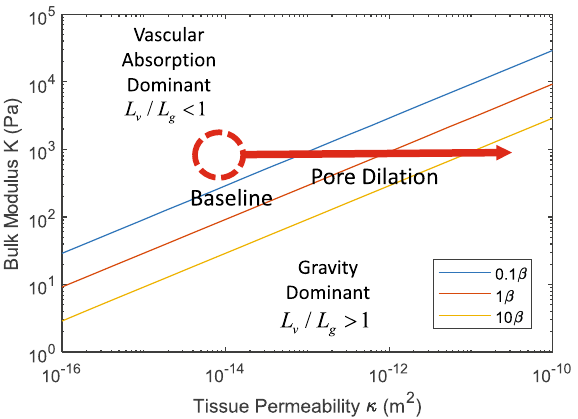
Figure 6. Map based on Eq. (14) showing how vascular absorption dominates at the baseline conditions of high tissue stiffness K and low tissue permeability κ , while gravity-driven pooling in the interstitium dominates for low tissue stiffness and high tissue permeability that can arise from dilation of the interstitial pore space. The lines of constant β = β c + β L determine when transition from vascular absorption dominance to gravity dominance occurs with the baseline conditions indicated by 1 β .